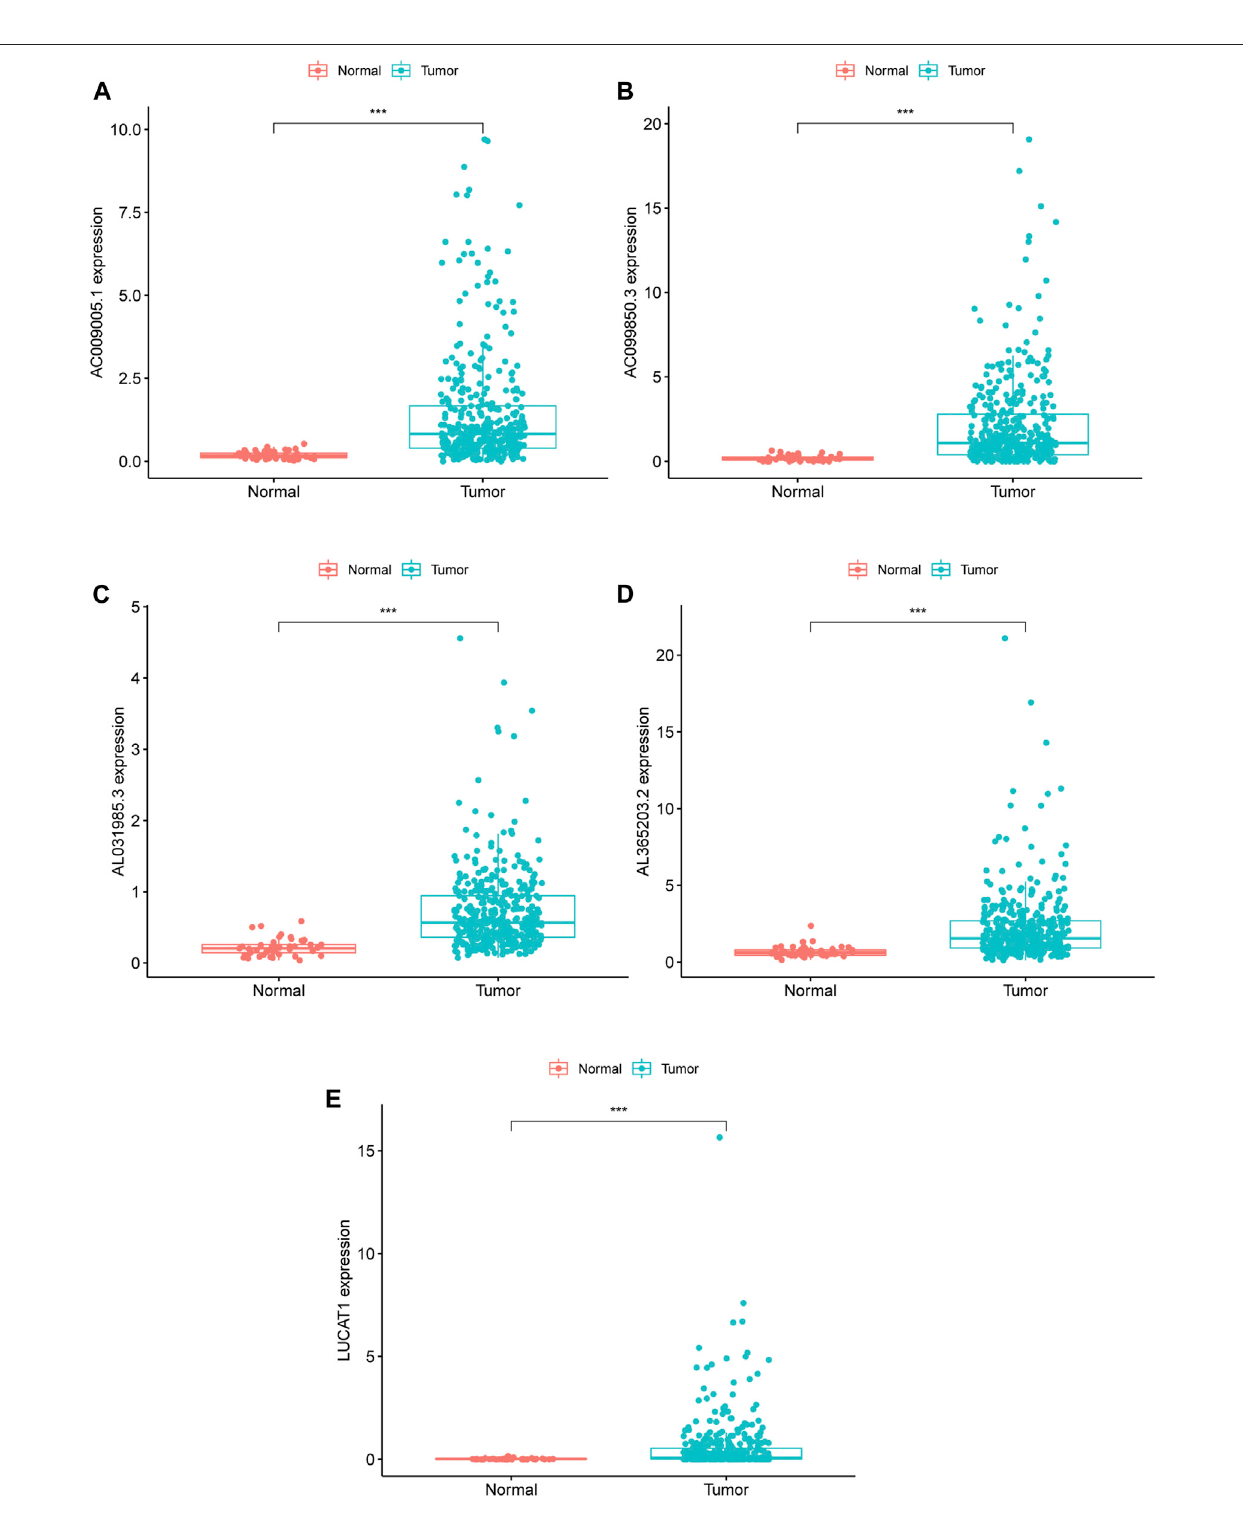
FIGURE 2 | RNA expression of fi ve ferroptosis-related lncRNA in TCGA database, (A – E) Differentially expressed lncRNA in tumor and adjacent normal tissues of HCC patients; (A) AC009005.1 (B) AC099850.3 (C) AL031985.3 (D) AL365203.2 (E) LUCAT1. ***means p value less than 0.001. HCC: hepatocellular carcinoma.